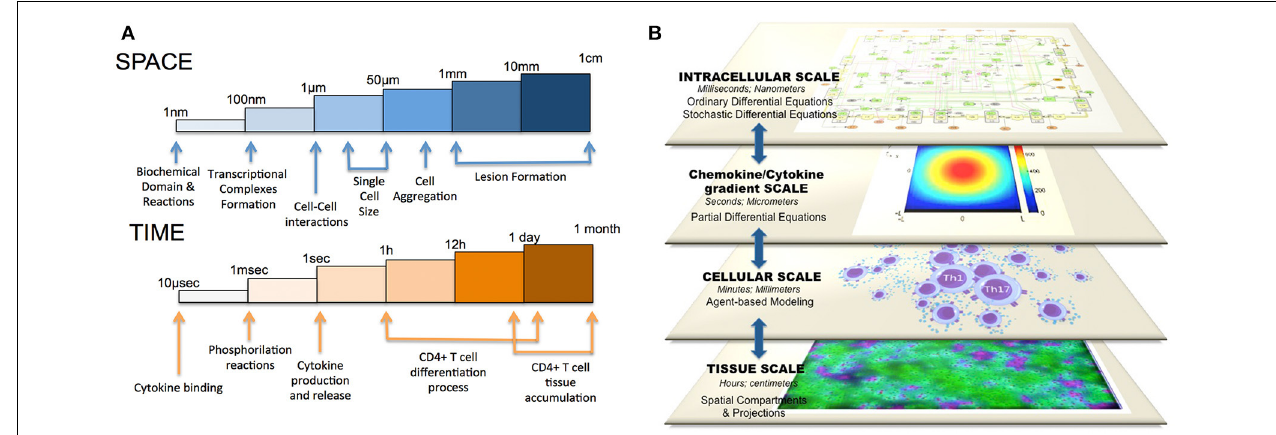
FIGURE 3 | Multiscale modeling of CD4 + T cell differentiation. The CD4 + T cell differentiation process comprises (A) different spatiotemporal parameters (milliseconds to hours and nanometers to centimeters) as well as (B) different scales (intracellular, difussion gradient, cellular, and tissue-level scale).